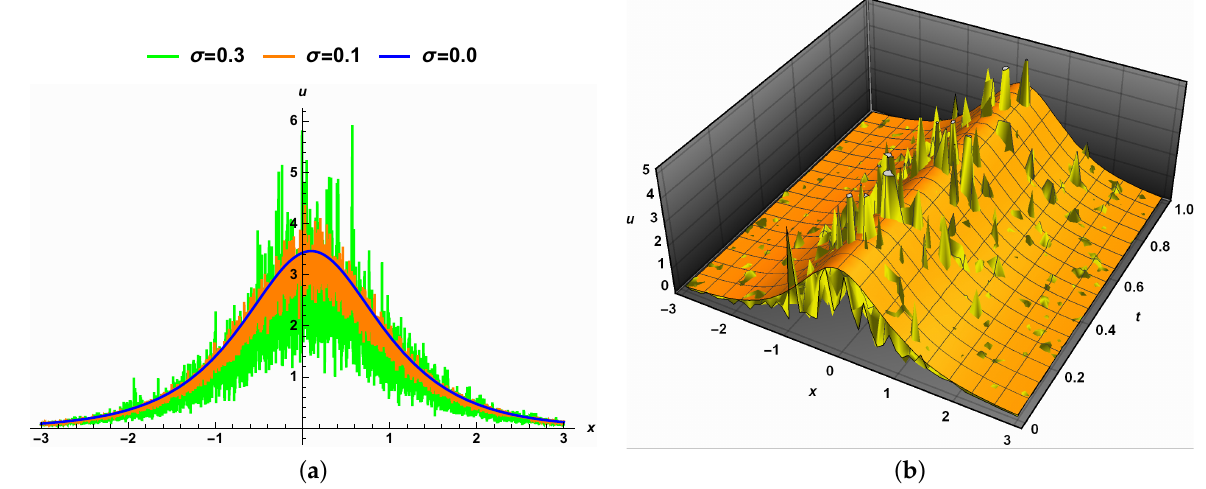
Figure 6. The effect of the noise on the solution (27) when α → 1.